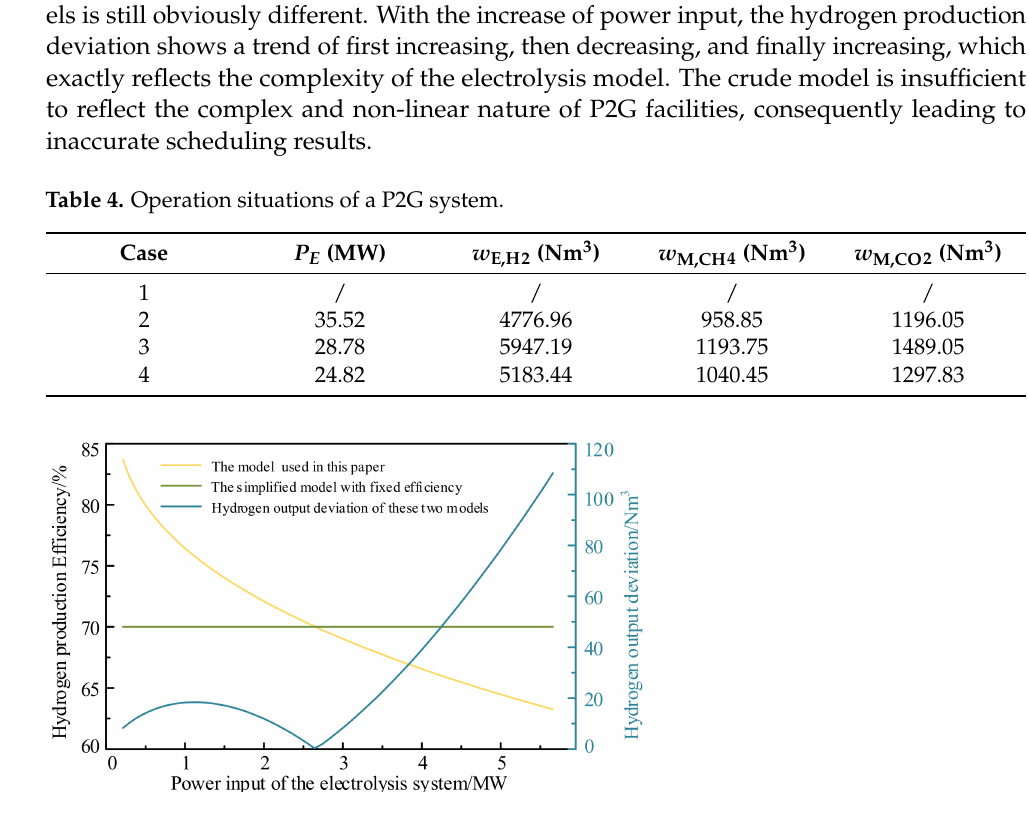
Figure 5. Hydrogen production efficiency and the hydrogen output deviation between the non-linear model in this paper and the simplified